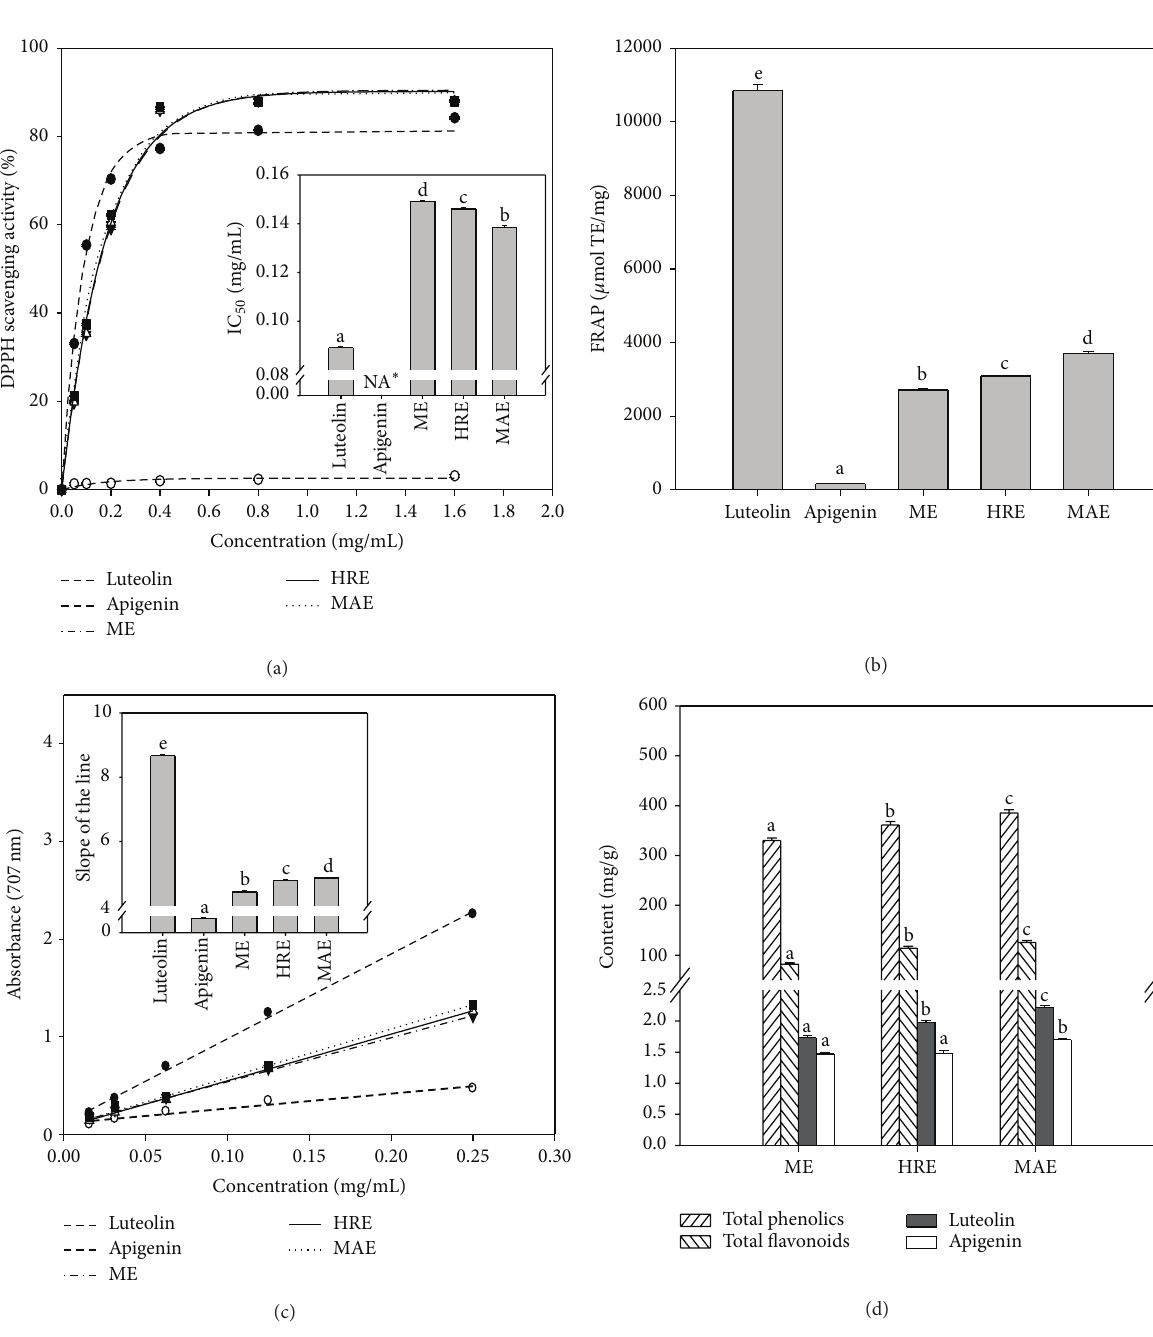
Figure 4: Antioxidant activity and antioxidants contents of crude extracts obtained by ME, HRE, and MAE of tree peony pod. (a) DPPH scavenging activity of the crude extracts; (b) FRAP of the crude extracts; (c) reducing power of the crude extracts; (d) total phenolics, total flavonoids, luteolin, and apigenin contents of the crude extracts. The values represent means ± standard deviation. Values followed by the same letter in the same assay are not significantly different ( 𝑃 > 0.05 , 𝑛 = 3 ). Note: ∗ means the value of IC 50 cannot been